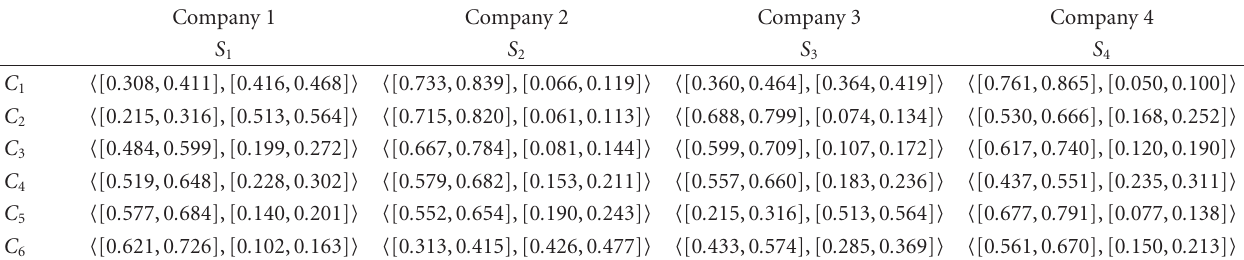
Table 11: Aggregated IVIF decision matrix.